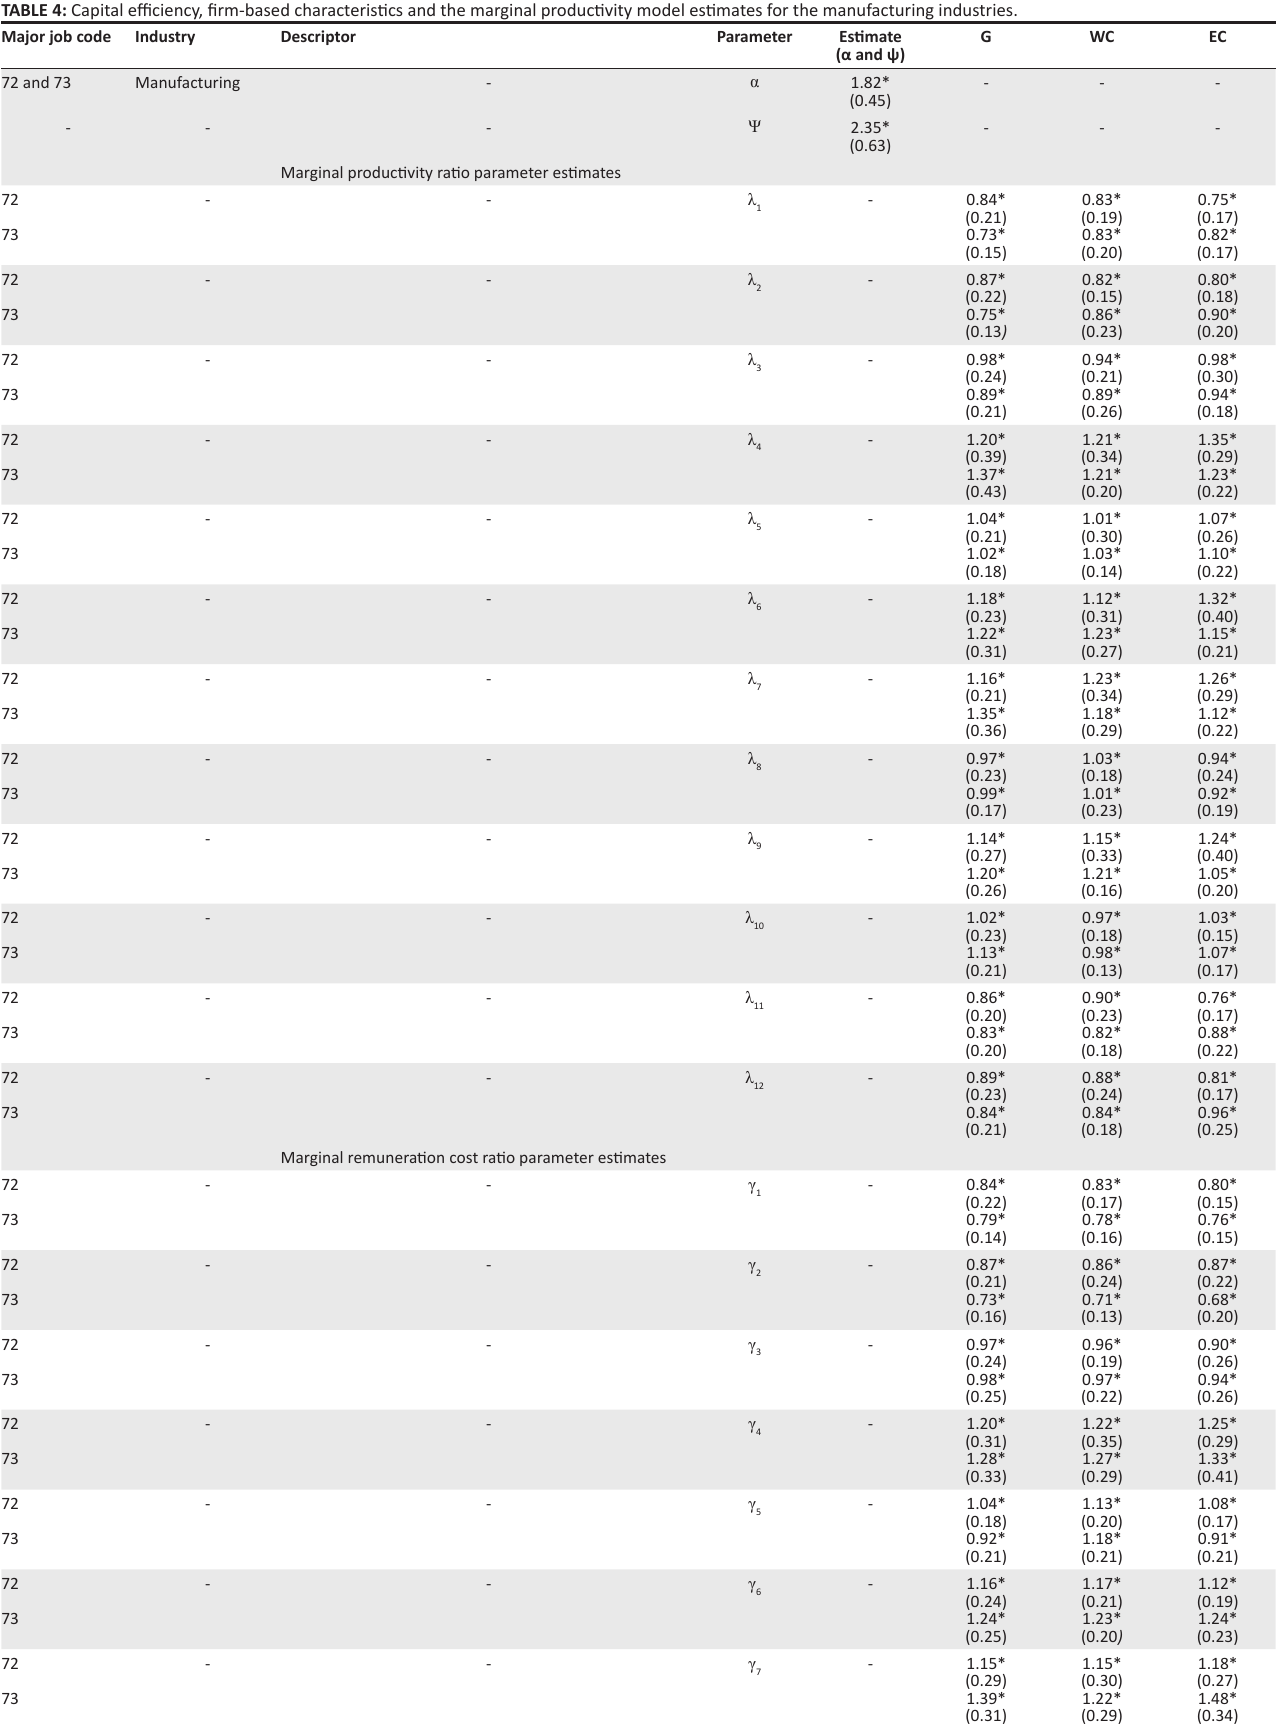
TABLE 4: Capital efficiency, firm-based characteristics and the marginal productivity model estimates for the manufacturing